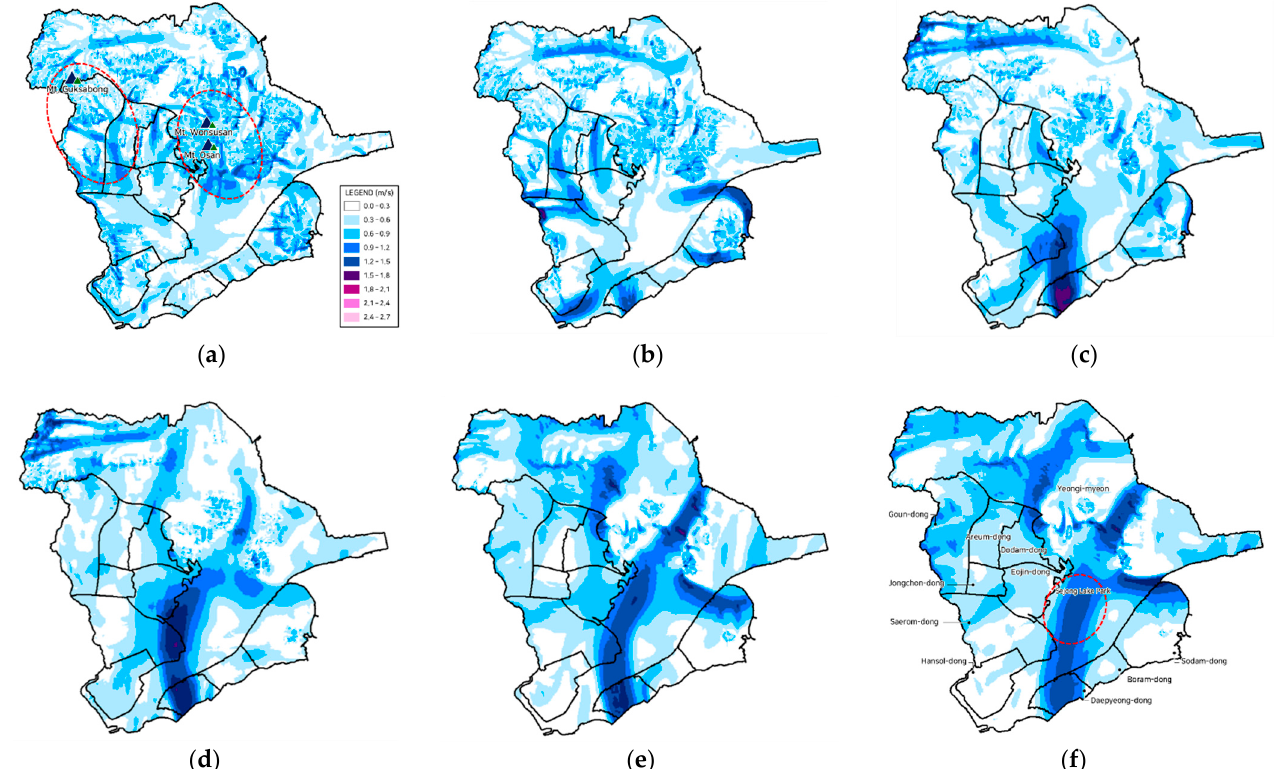
Figure 8. The speed of cold air flow by minute after the start of cold air generation in HBC region: ( a ) 60 min; ( b ) 120 min;